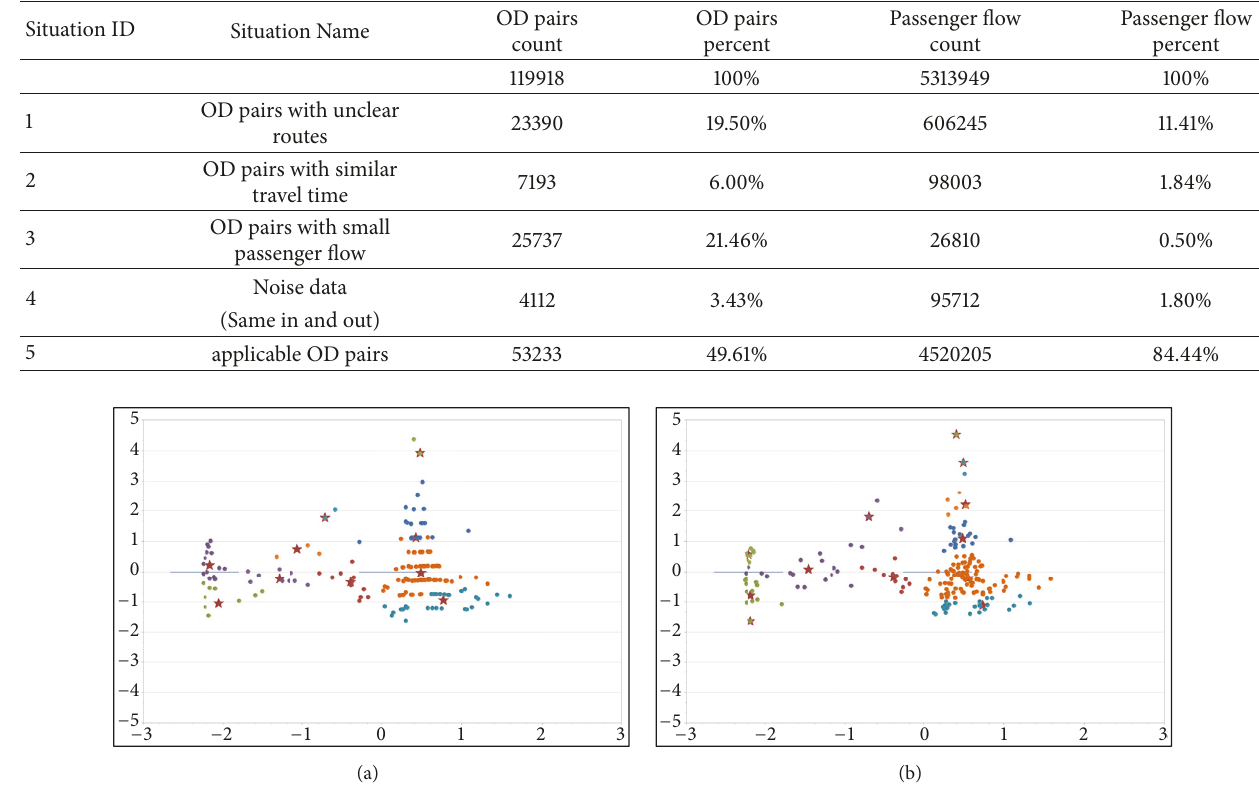
Figure 10: Comparison of cluster results after and before data